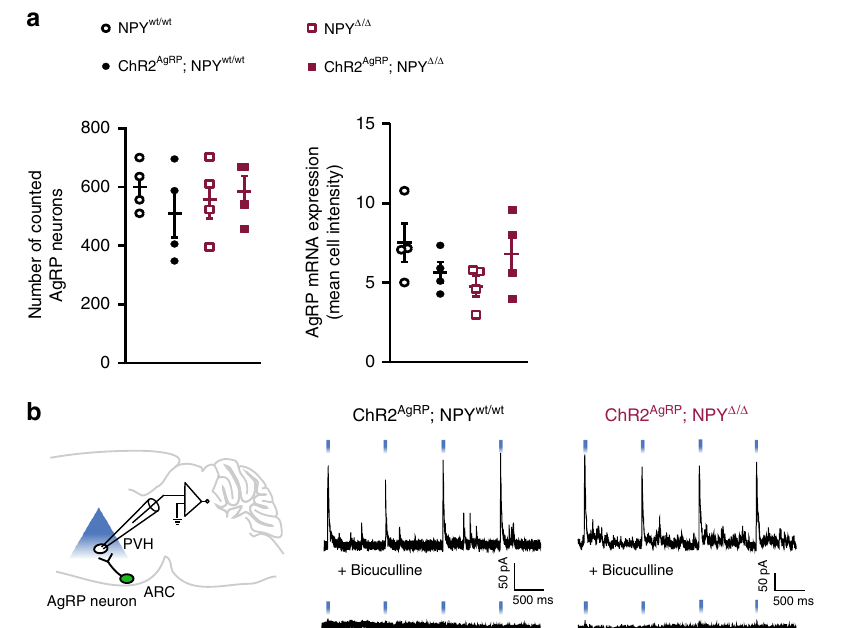
Fig. 2 NPY-de fi cient mice retain AgRP expression and GABA release. a Graphs showing that AgRP mRNA levels, as determined by number of neurons (left) as well as mean cell intensity (right), do not differ between genotypes ( n = 4 per group). b Schematic representation of the electrophysiological approach (left) and recording examples (right) of light-evoked GABAergic IPSCs in PVH neurons in ChR2 AgRP ; NPY wt/wt and ChR2 AgRP ; NPY Δ / Δ mice ( n = 2 mice per group). Data are shown as mean ± s.e.m. Source data are provided as a Source Data fi le.